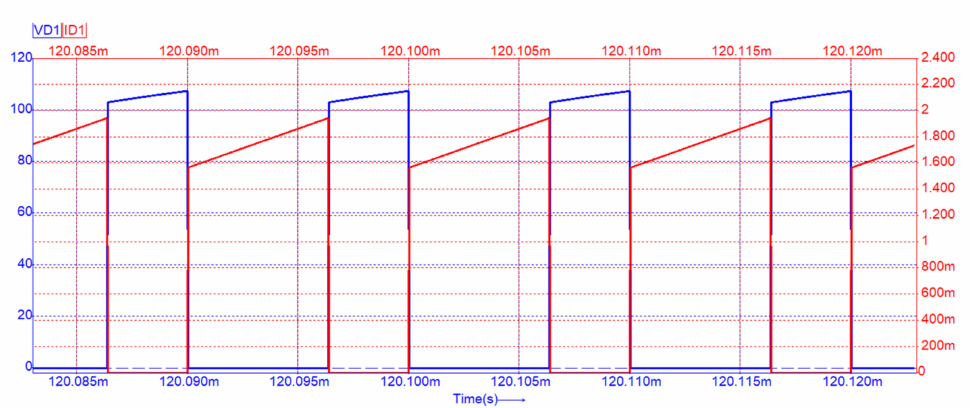
Figure 16. Voltage and current corresponding to the diode D 1